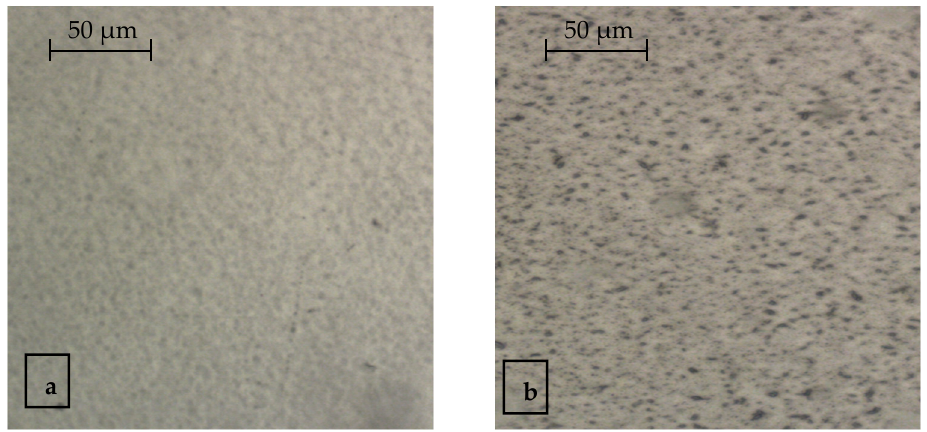
Figure 6. Surface microstructure of modified PA/LDPE film: ( a ) PA/LDPE (control), ( b ) PA/LDPE (0.5% additive in polyethylene layer).